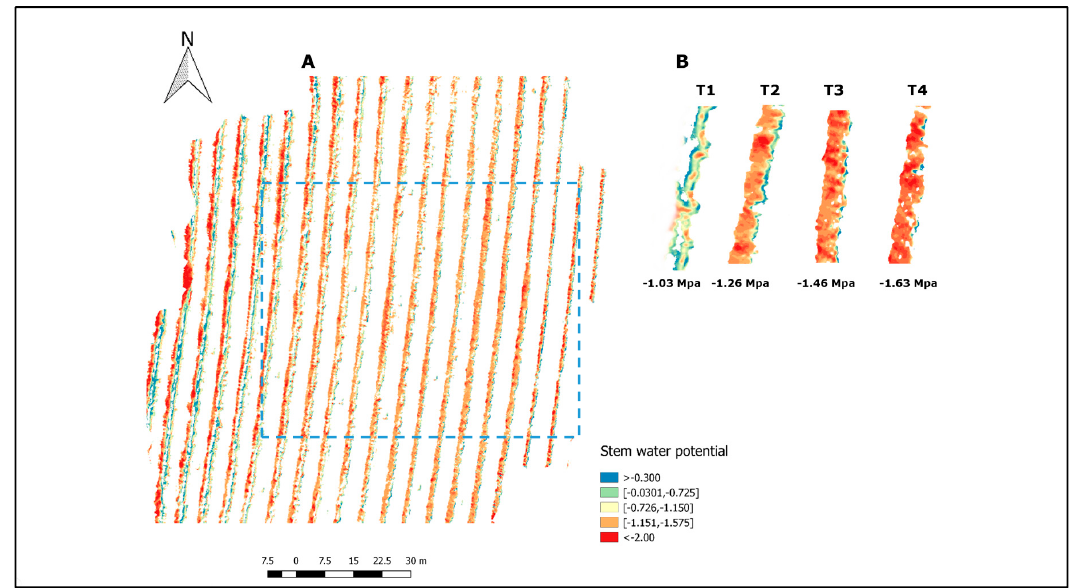
Figure 5. Predicted values of stem water potential ( Ψ stem ) for a whole flight. ( A ) All pure-canopy pixel information within the vineyard. ( B ) Predicted Ψ stem classification within the four treatments.